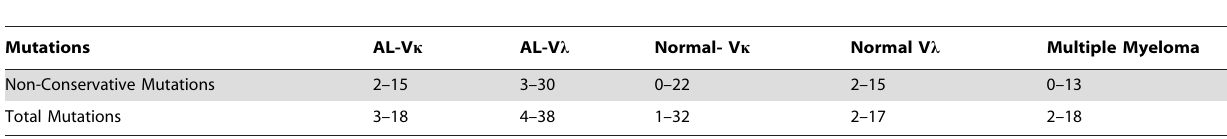
Table 2. Comparison of the ranges of non-conservative of mutations and total number of mutations for all the protein sequences.